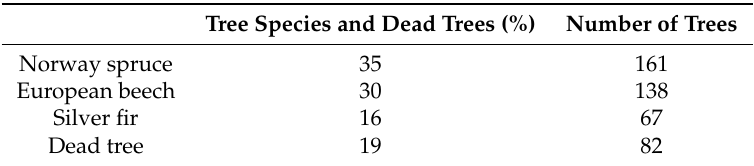
Table 4. The number of matched trees in the upper canopy layer with the overall percentage of tree species and dead trees in the